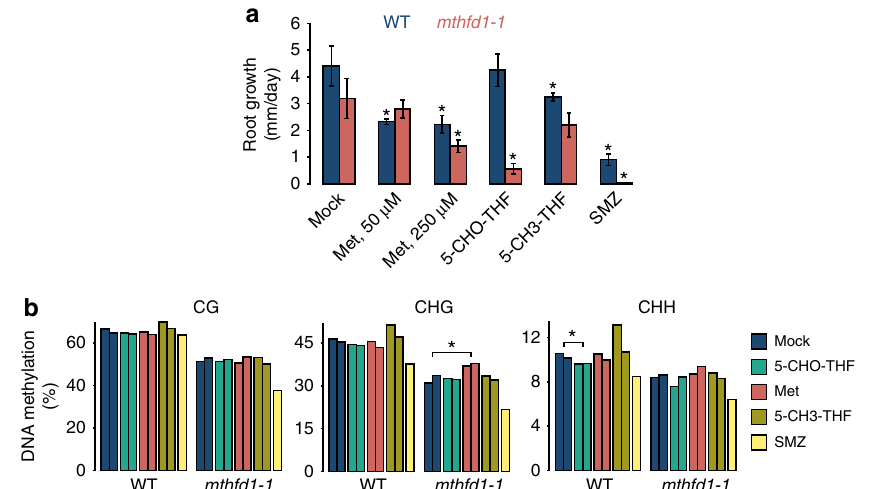
Figure 8 | mthfd1-1 mutants are hypersensitive to exogenous 5-CHO-THF but tolerant to exogenous methionine. ( a ) Root growth of seedlings on solid media containing mock, Met, 0.5mM 5-CHO-THF, 0.5mM 5-CH3-THF or 5 m M SMZ. Mean values ± s.d. ( n ¼ 3) are shown. ( b ) Average CG, CHG and CHH methylation levels at previously defined mthfd1-1 CG, CHG and CHH hypo-DMRs, respectively, in seedlings grown for 14 days on solid media containing mock, 0.1mM Met, 0.5mM 5-CHO-THF, 0.5mM 5-CH3-THF or 5 m M SMZ. Two biological replicates are shown, except for SMZ. * indicates significant difference between mock and chemical treatment ( P o 0.05, Student’s t